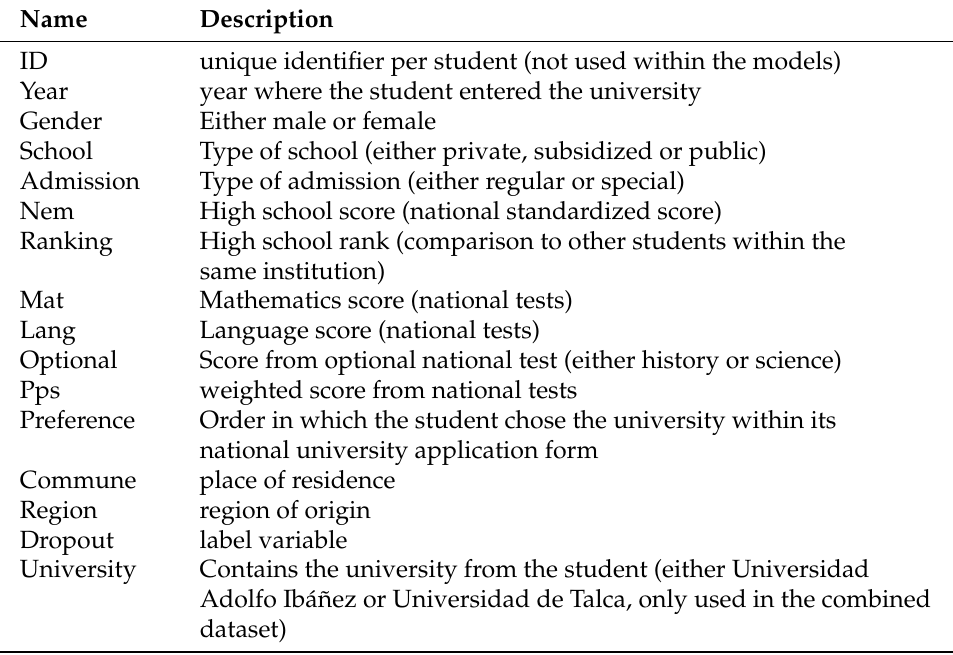
Table 1. Common variables within the